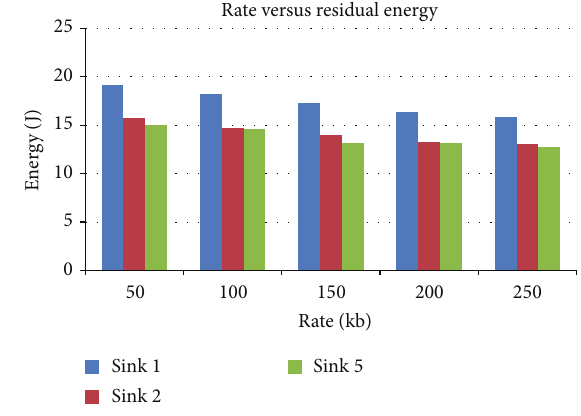
Figure 10: Rate versus energy in terms of sink.